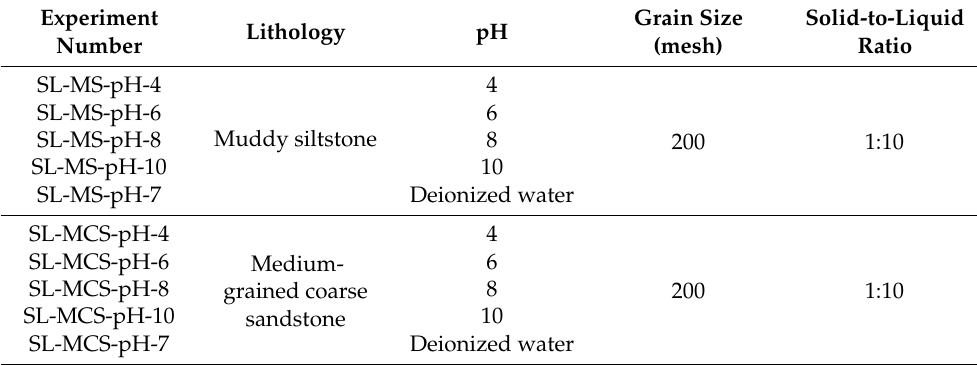
Table 1. Static leaching test